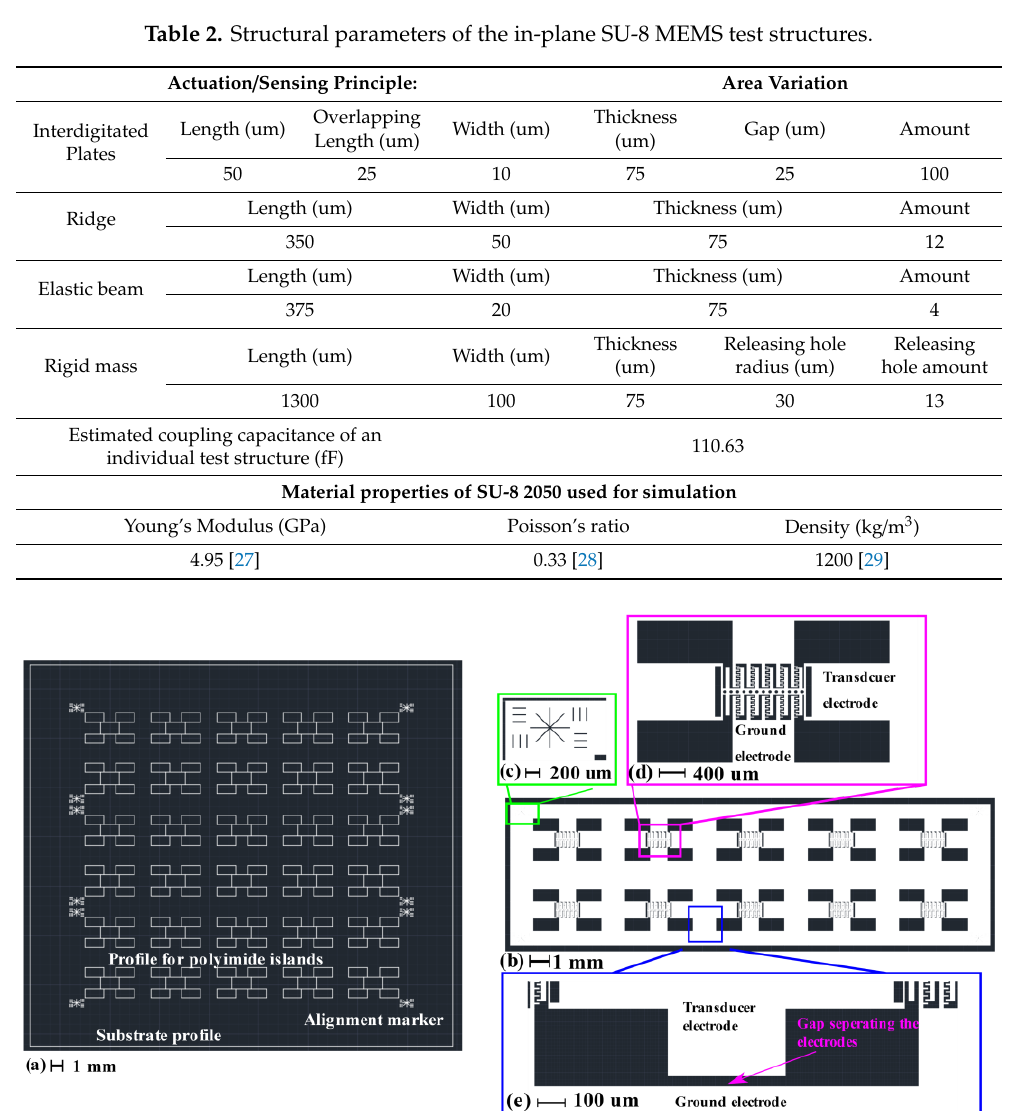
Figure 5. Mask files used to fabricate the in-plane MEMS test structures. ( a ) Mask for laser micromachining of the polyimide layers; ( b ) Lithography mask for the test structures; ( c ) Zoom-in view of the alignment markers; ( d ) Zoom-in view of MEMS structures; ( e ) Zoom-in view of the gap separating the transducer electrodes from the ground electrodes.